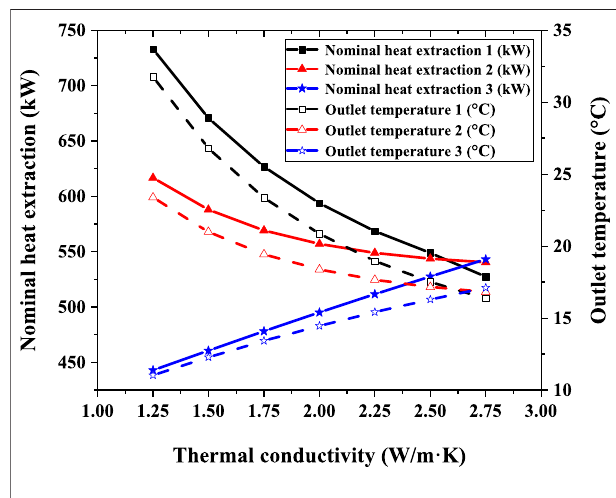
FIGURE 6 | Nominal heat extraction under different thermal conductivities of a single soil